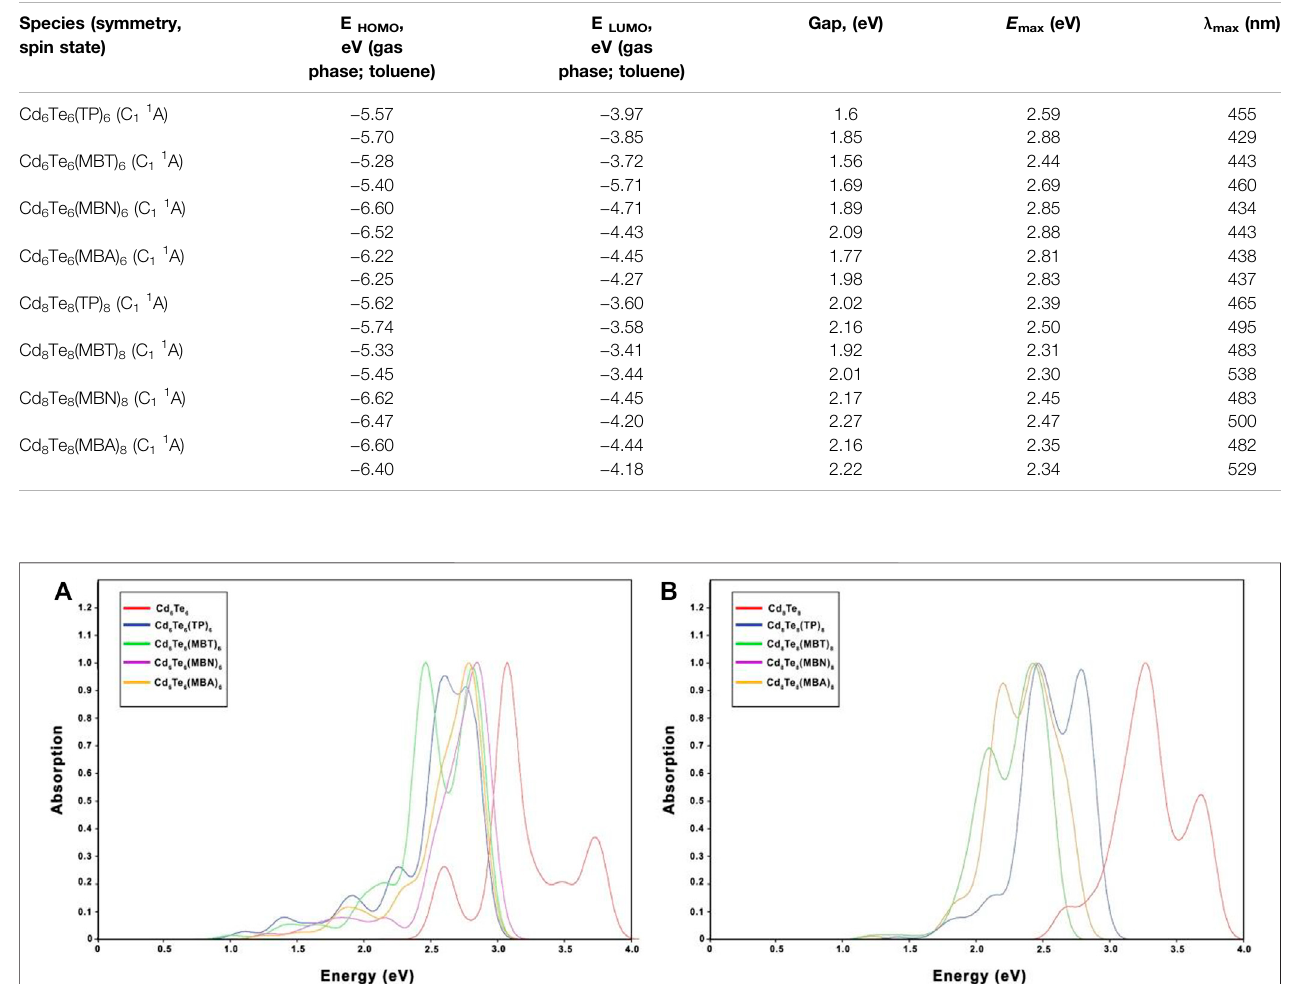
Frontiers in Materials |